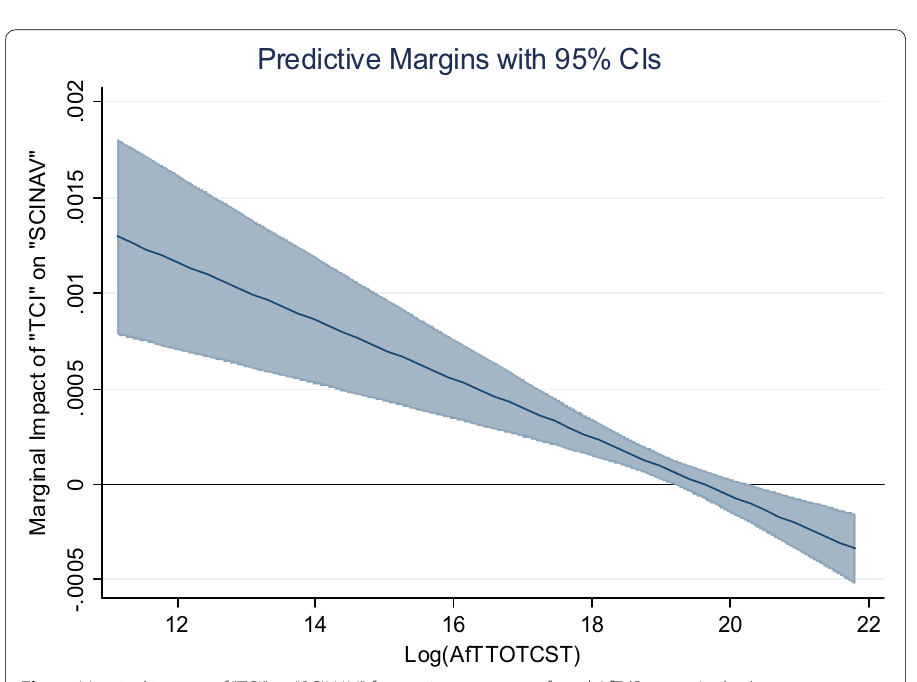
Fig. 4 Marginal impact of “TCI” on “SCINAV”, for varying amounts of total AfT (Source: